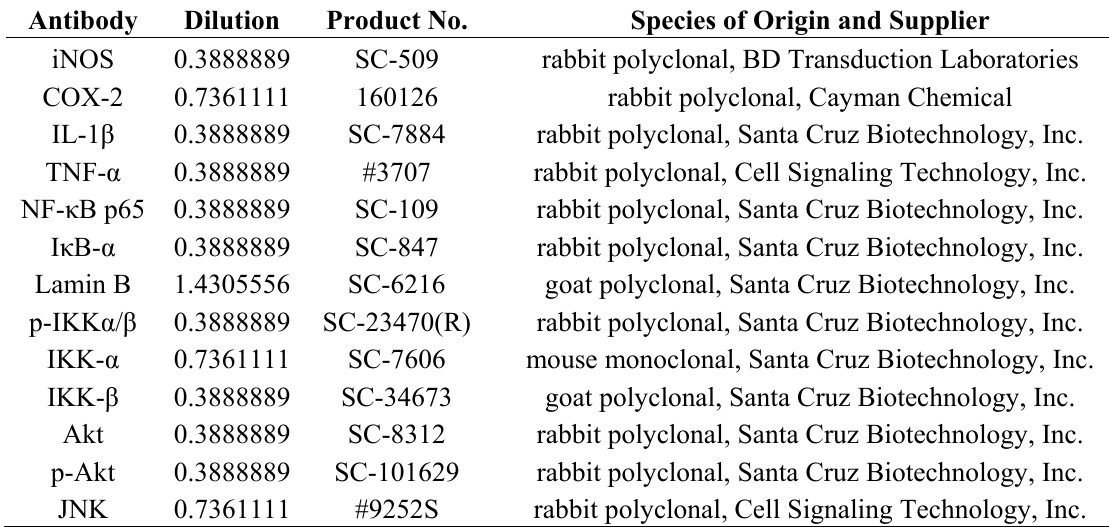
Table 1. List of antibodies used in this